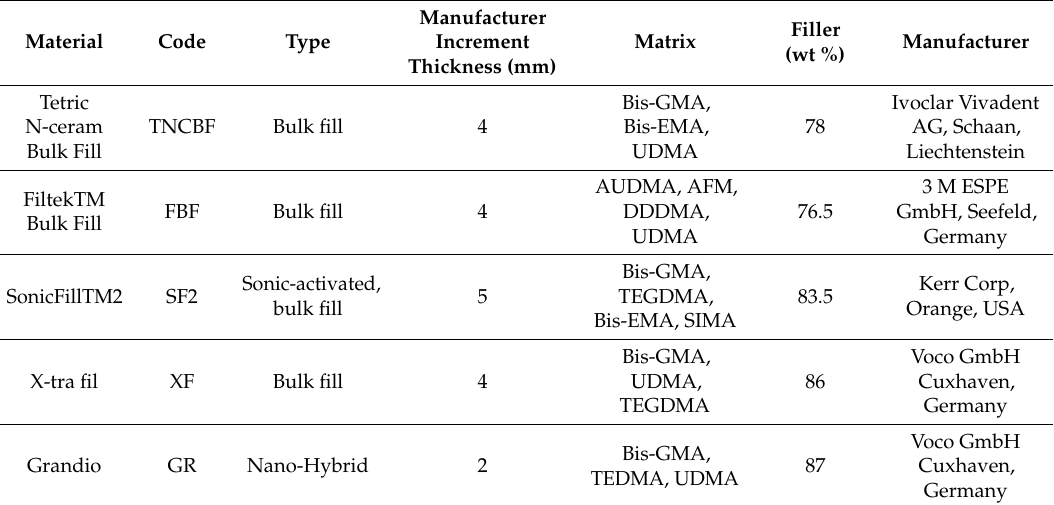
Table 1. Specifications of the studied materials.